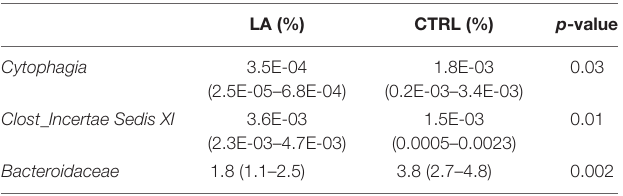
TABLE 3 | Set of microbial taxa (class, order, and family) differentially present in lifelong athletes (LA) and the sedentary elderly (CTRL).